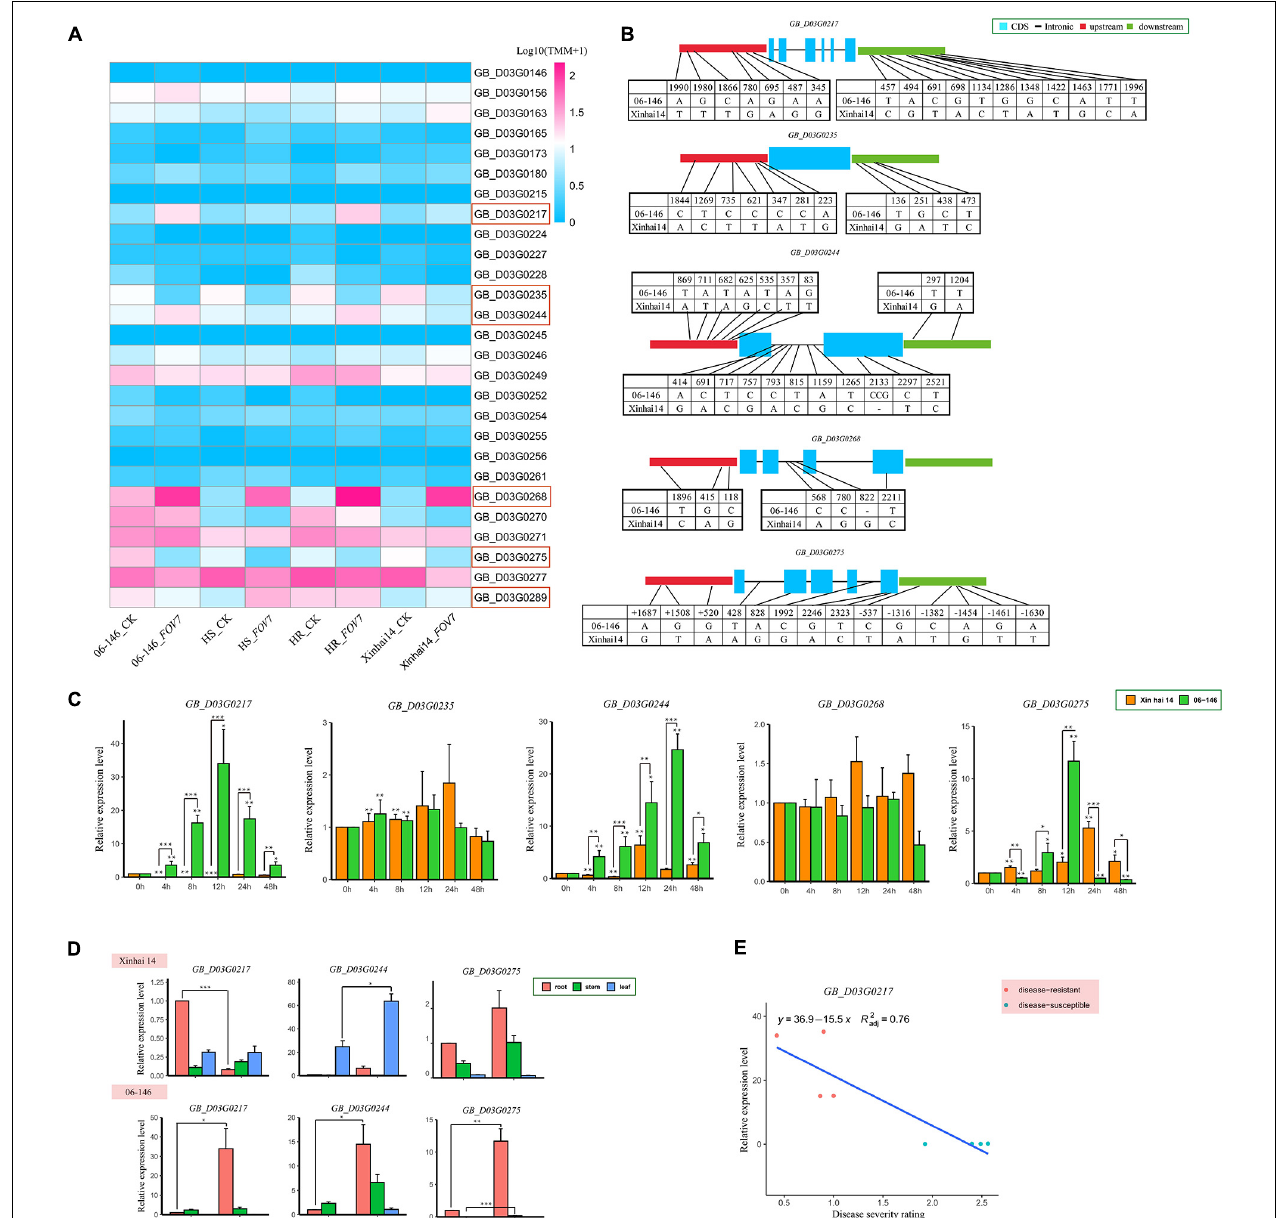
FIGURE 4 | (A) Expression analysis of 27 genes from the parent and RIL populations under FOV7 stress based on transcriptome data. (B) SNP and Indel information between Xinhai 14 and 06-146. (C) Expression profiling of five candidate genes related to FOV7 resistance. The error bars represent the means of three replicates ± SEs. Statistically significant differences from the control group are indicated with * P < 0.05; ** P < 0.01; and *** P < 0.001. (D) Tissue-specific expression analysis of three candidate genes related to FOV7 resistance. The error bars represent the means of three replicates ± SEs. Statistically significant differences from the control group are indicated as * P < 0.05; ** P < 0.01;*** P < 0.001. (E) Expression patterns of the GB_D03G0217 gene in apical organs of eight lines inoculated with FOV7, detected by qRT–PCR; red and blue dots indicate four FOV7-resistant lines and four FOV7 susceptible lines,